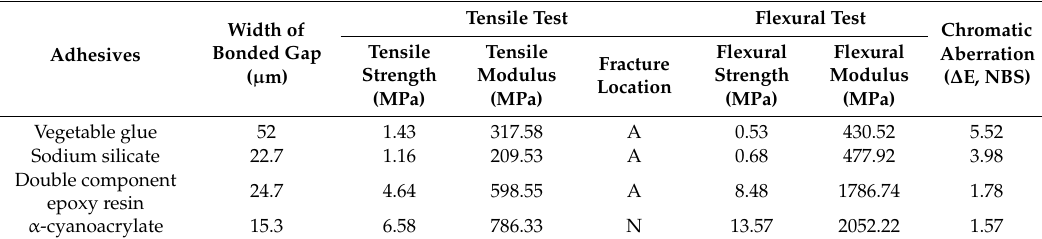
Table 3. Parameter values related to seamless adhesion of four adhesives.